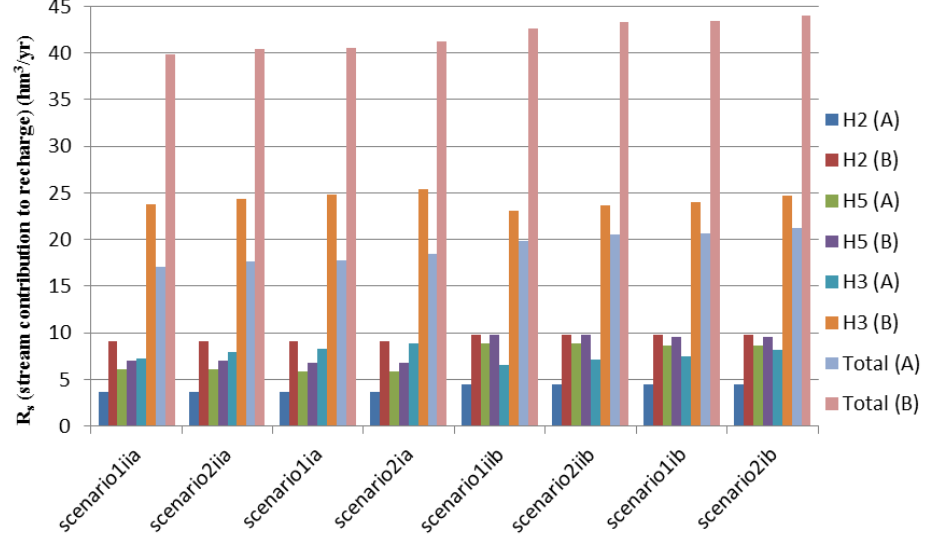
Fig. 2. Total stream recharge and for individual stream gauges (see Fig. 1 for location) for different tested scenarios (see Table 1 for detailed scenario descriptions). (A) and (B) refer to surface runoff generated within the aquifer area considering areal recharge rates from Vieira and Monteiro (2003) and BALSEQ MOD (Oliveira et al., 2008),